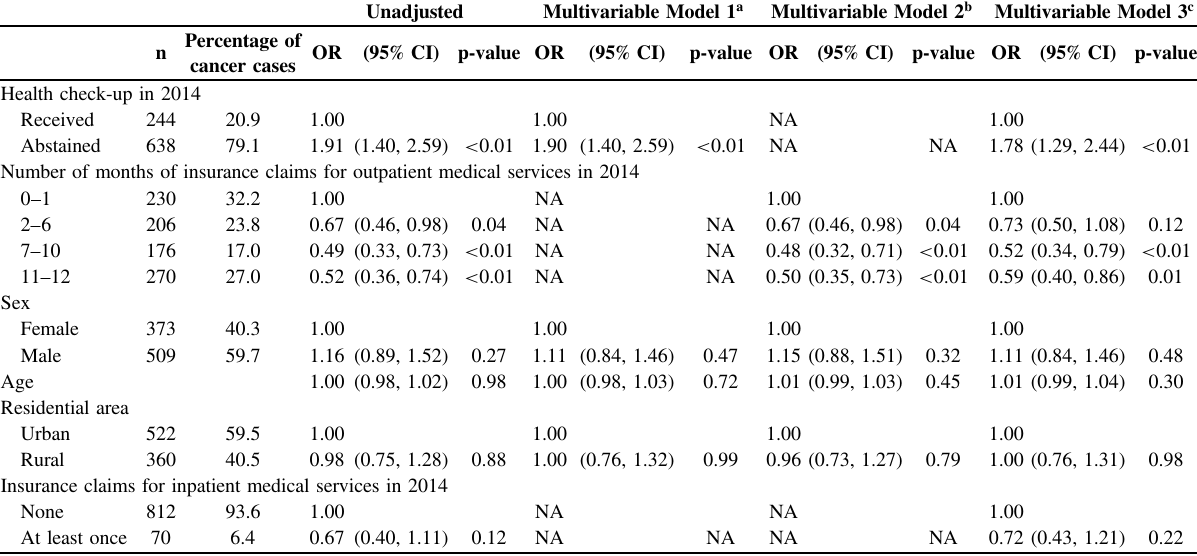
Table 4 Risk of advanced cancer diagnosis among individuals who were diagnosed with any cancer in 2017 (N = 882; 407 advanced cancer cases) Unadjusted Multivariable Model 1 a Multivariable Model 2 b Multivariable Model 3 c